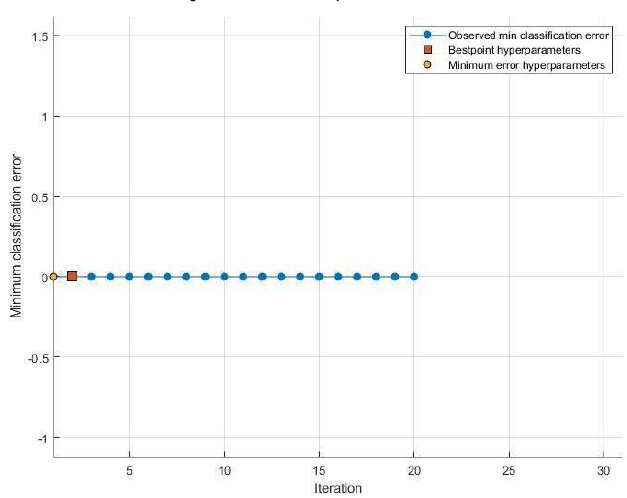
Fig. 21. SSL renegotiation minimum classification error of bayesian based optimized tree